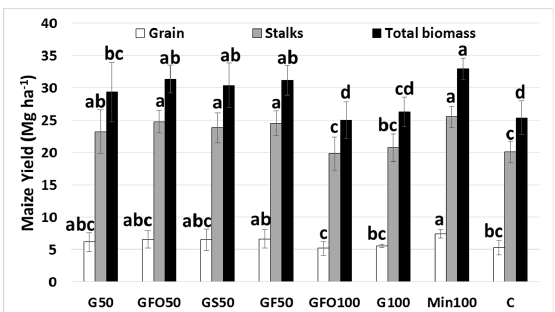
Figure 2. Maize dry biomass production: total biomass, stalk biomass, and grain yield. Histograms indicate average values while bars indicate standard deviation. Different letters indicate significant differences according to Tukey’s HSD test at p < 0.05 between treatments of the same biomass component. G50: 50% of N from G compost and 50% of N from mineral fertilization (MF). GFO50: 50% of N from G + F + O compost and 50% of N from MF. GS50: 50% of N from G + S compost and 50% of N from MF. GF50: 50% of N from G + F compost and 50% of N from MF. GFO100: 100% of N from G + F + O fertilization. G100: 100% of N from G compost. Min100: 100% of N from MF. C: Un-fertilized treatment. Both wheat total and straw biomasses showed the same statistical trend among fertilization treatments (Figure 3). The significantly highest values were recorded in the treatments where mineral fertilizers were used at either 50% or 100%, without any significant differences among them, whereas the significantly lowest ones (ANOVA, p < 0.05) were obtained in the unfertilized treatment (Figure 3) and grain yield did not give significant differences among treatments with an average value of 5.1 ± 0.7 Mg ha − 1 (Figure 3).